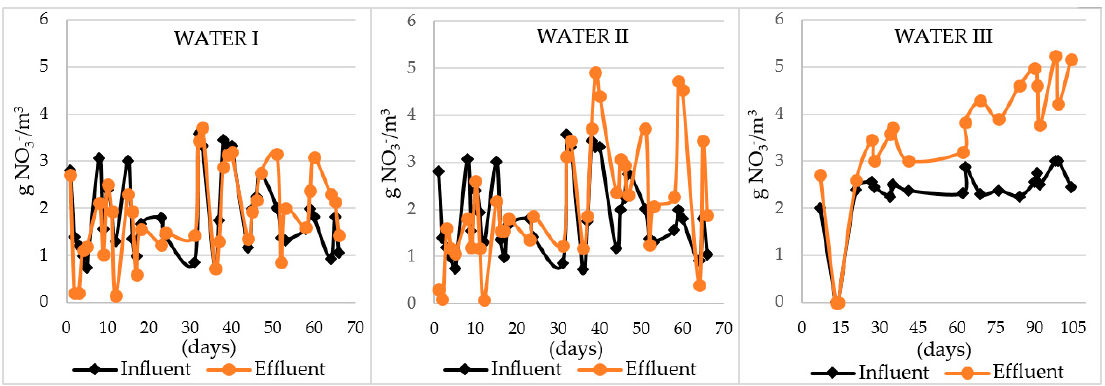
Figure 4. Change in the content of nitrate nitrogen compounds after biofiltration on the chalcedonite bed in the analyzed systems.